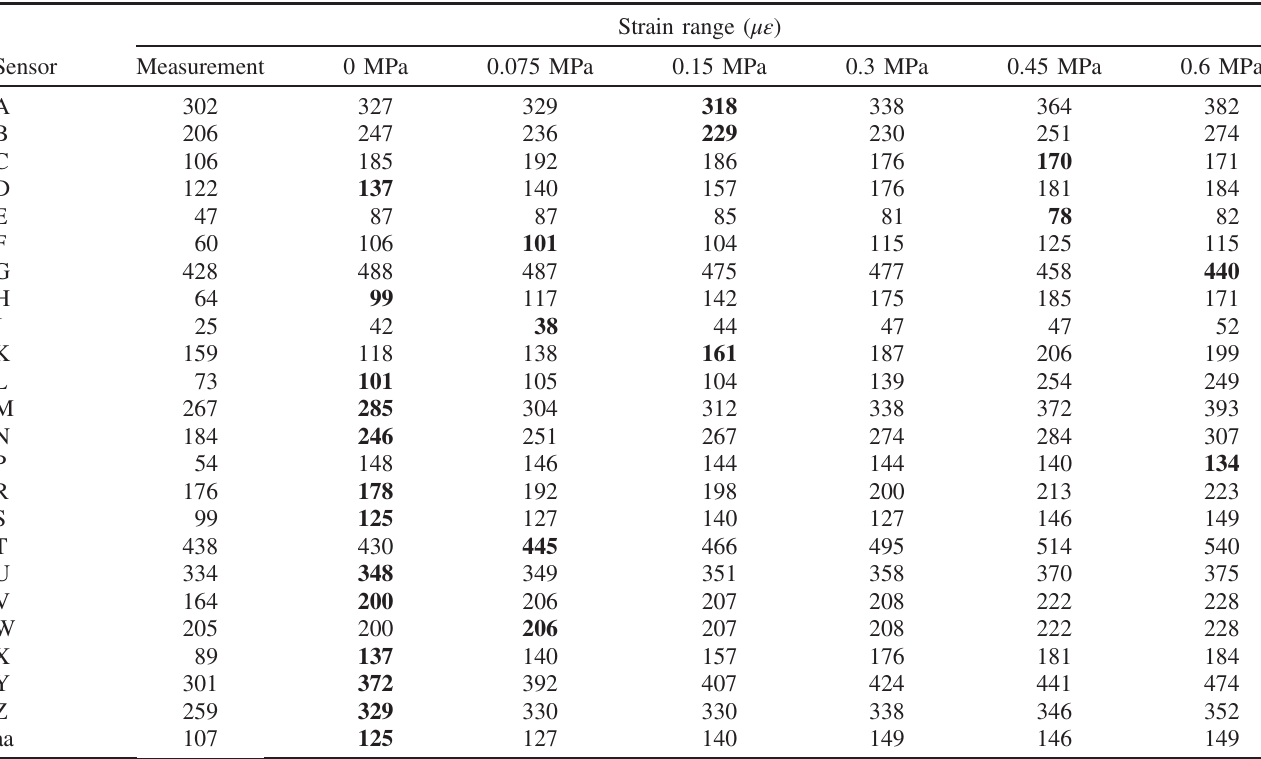
TABLE V. Strain range comparison between predictions with different mercury tensile cutoff pressure and measurement. The bold value for each sensor is the simulation result with the tensile cutoff pressure that is closest to the corresponding measurement value.